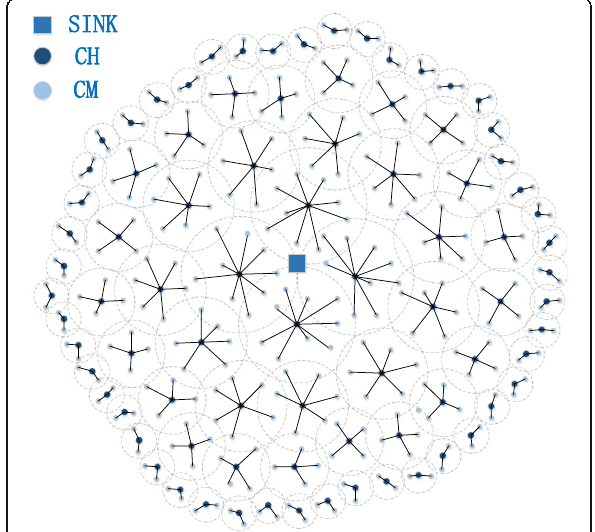
Fig. 1 Clustering method with different cluster